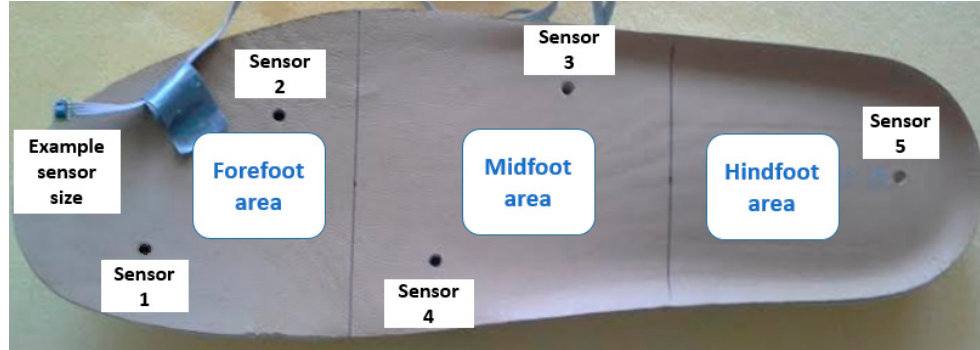
Figure 4. The five sensors were placed in insoles of both the left and right footwear, with the following division of the foot: two sensors for the forefoot, two sensors for the midfoot, and one sensor for the hindfoot.